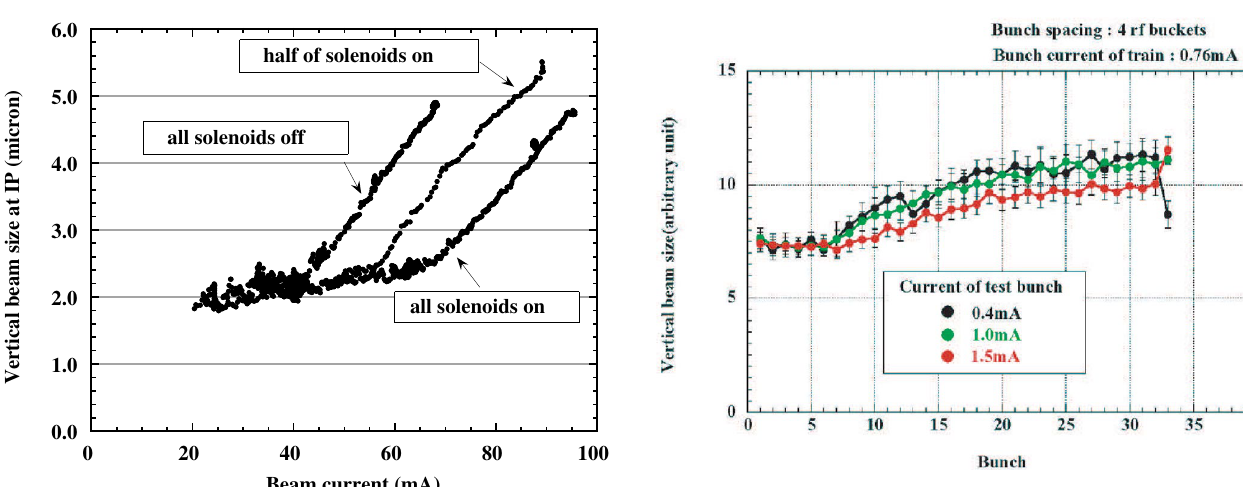
FIG. 13. Vertical beam size of the KEKB LER positron beam as a function of the beam current measured by the synchrotron- light interferometer in 2000 [95]; two trains with 60 bunches each were injected on opposite sides of the ring; the bunch spacing was four rf buckets; the effect of the first set of solenoids covering an effective length of 800 m is